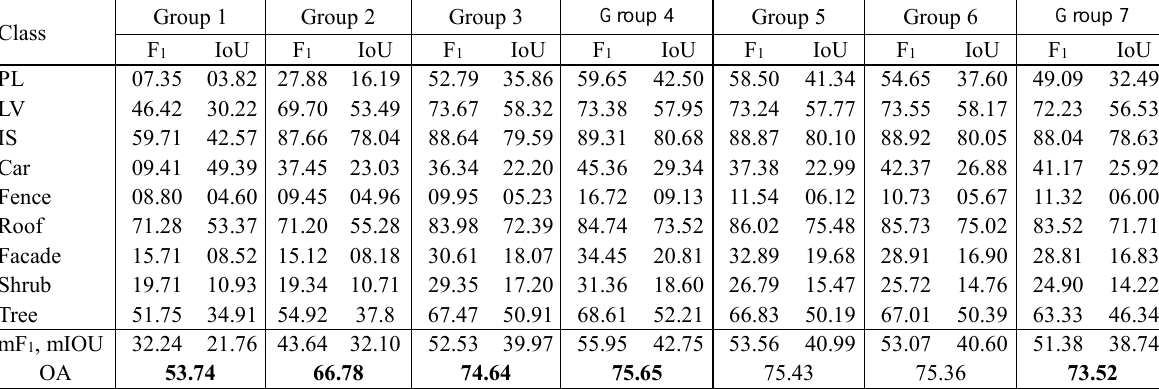
Table 2. Classification results (in percentage, %) of the proposed algorithm for the Vaihingen test (Scenes 1, 2) data set. The performance metrics are F 1 -score (F 1 ), mean F 1 (mF 1 ), Intersection over Union (IoU), mean IoU (mIoU), and Overall Accuracy